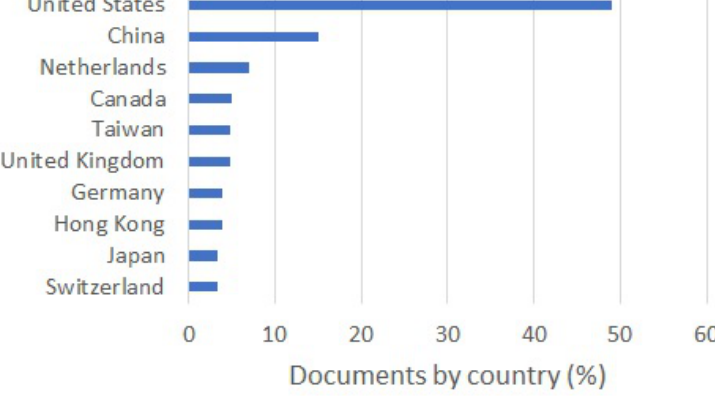
Figure 3. Distribution of the published documents on dynamic toll pricing by country.